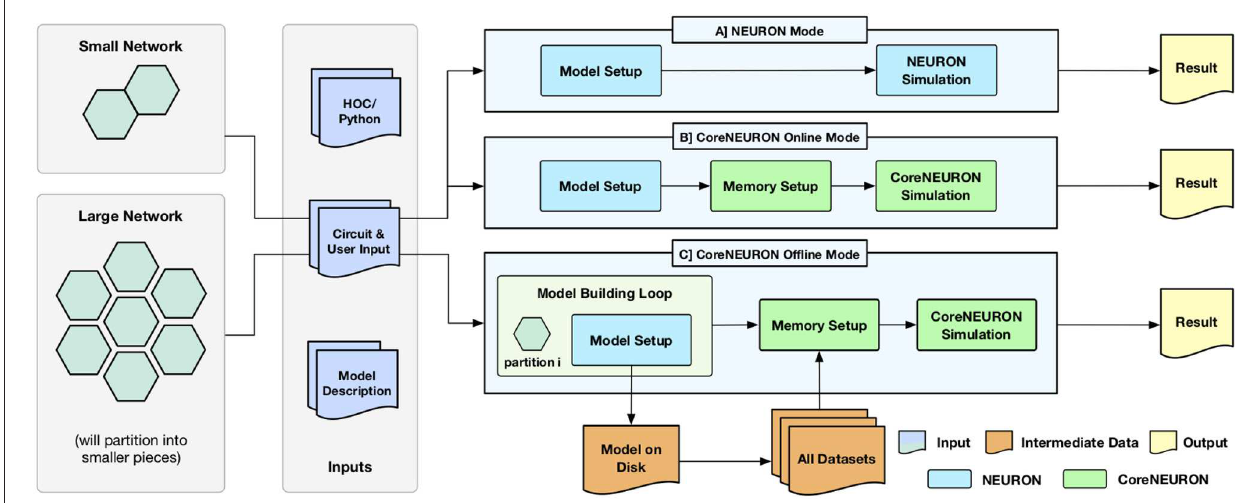
FIGURE 1 | Different execution workflows supported by NEURON simulator with CoreNEURON : (A) shows the existing simulation workflow where HOC/Python interface is used for building a model which is then simulated by NEURON; (B) shows the new CoreNEURON based workflow where the in-memory model constructed by NEURON is transferred using direct memory access and then simulated by CoreNEURON; (C) shows new CoreNEURON based workflow where NEURON partitions a large network model into smaller chunks, iteratively instantiates each model piece in memory, and copies that subset of model information to disk. CoreNEURON then loads the whole model in memory and simulates